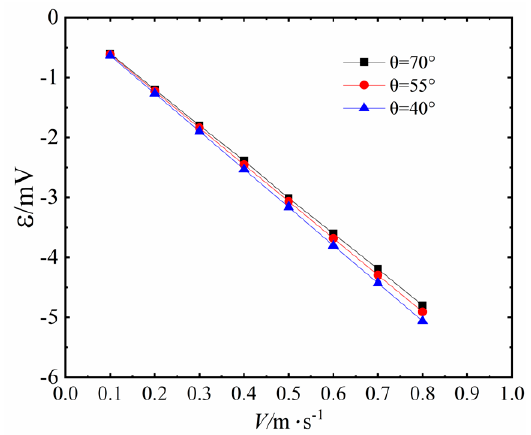
Figure 8. Variation of induced electromotive force with the fluid velocity of working fluid under different contact angles between working fluid and pipe wall.